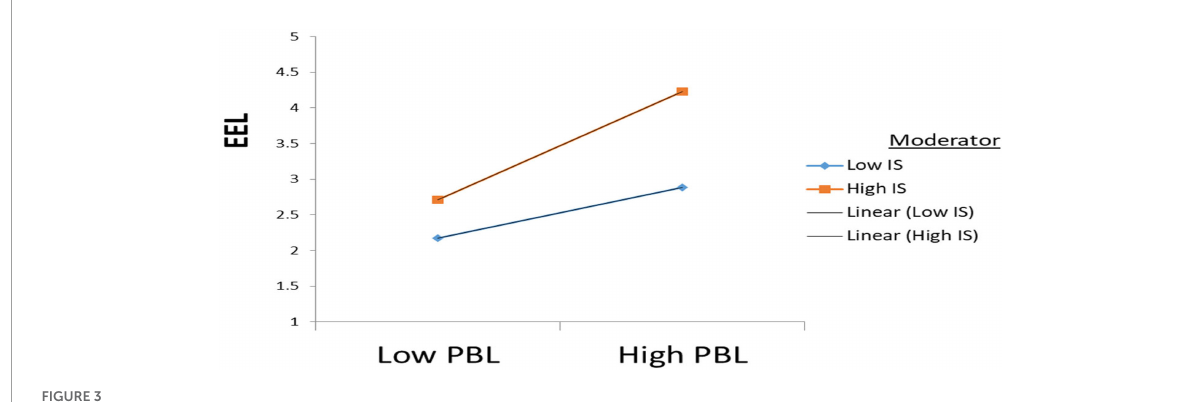
FIGURE3 Moderation results